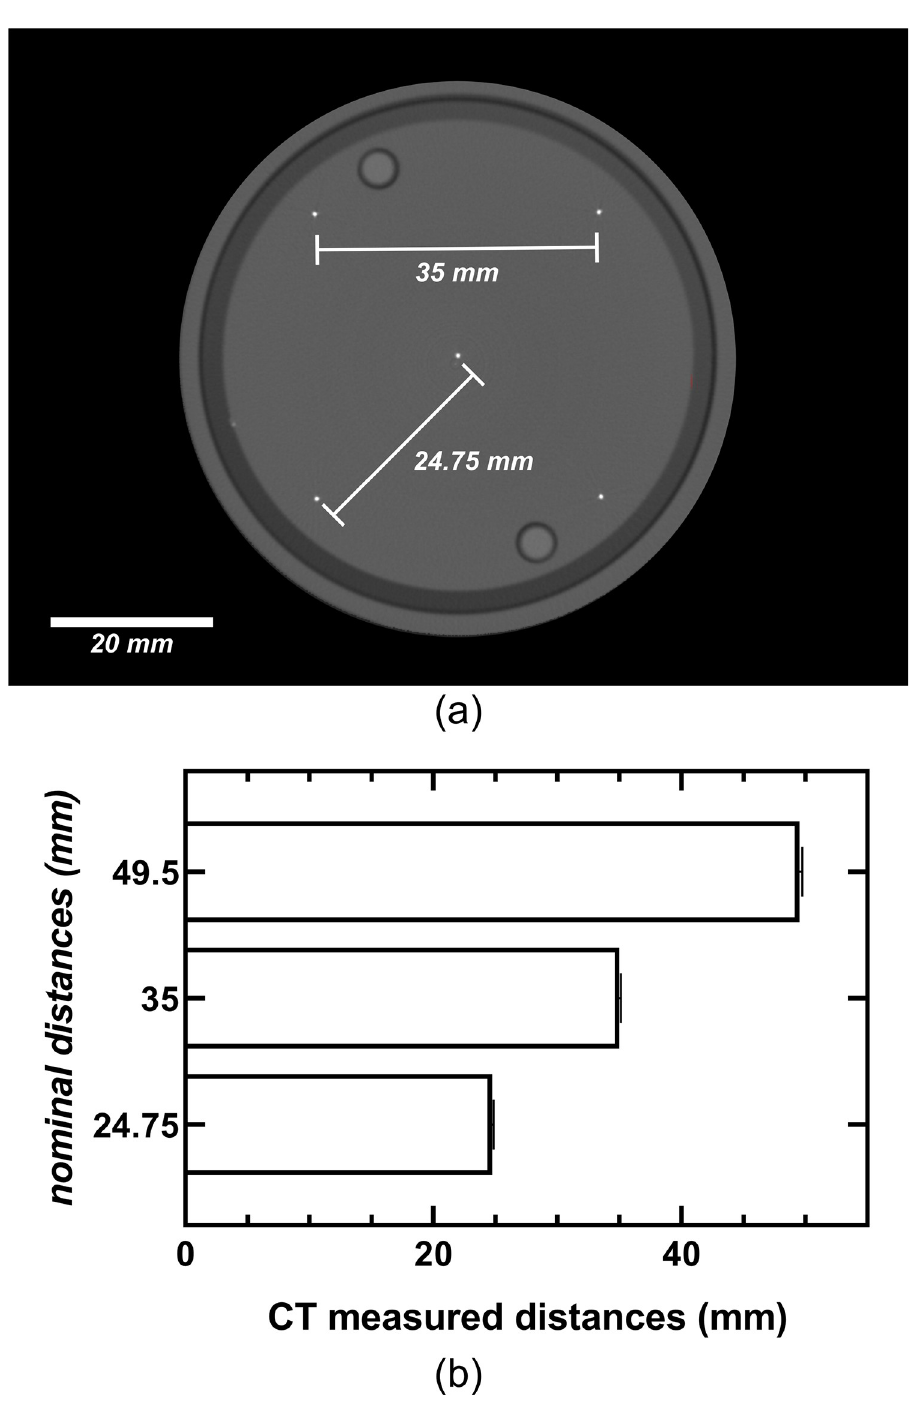
Fig 11. Geometric-accuracy plate. (a) reconstructed transaxial-slice CT image of the geometric-accuracy plate of the CT quality assurance phantom with four beads located at the periphery and 34.98 ± 0.06 mm apart and one central bead at a distance of 24.74 ± 0.01 mm from the other four. (b) all possible nominal versus CT calculated distances between beads depicting error bars that represent the 95% confidence interval.